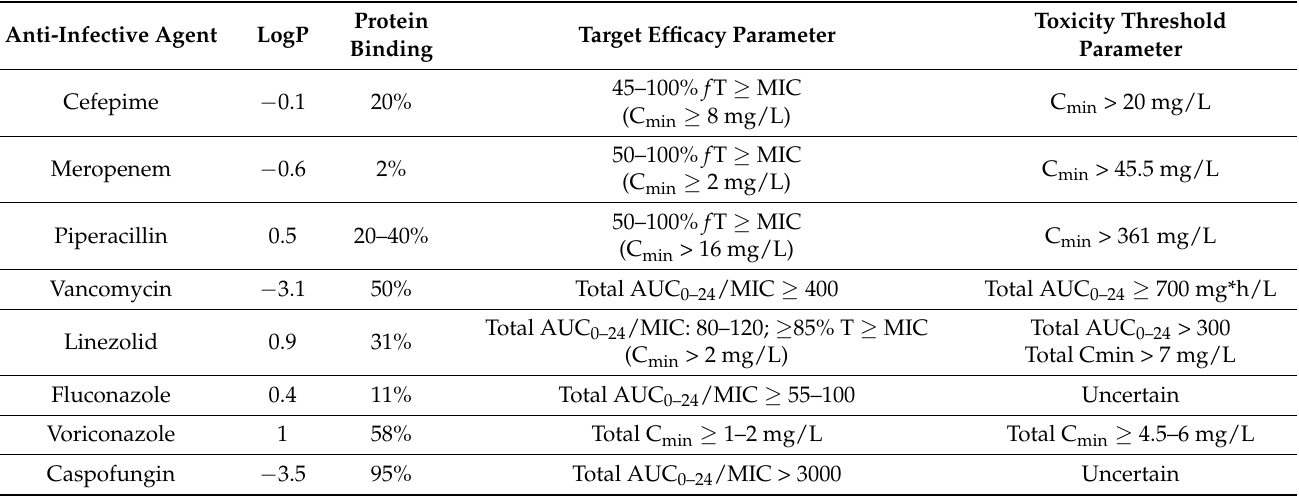
Table 1. Summary of anti-infective characteristics with target pharmacodynamic and toxicity